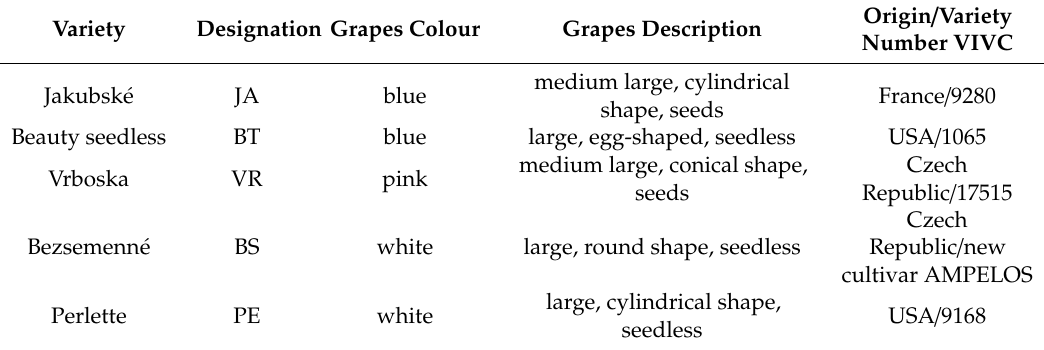
Table 1. Description of grape varieties included in the experiment. VIVC—Vitis International Variety